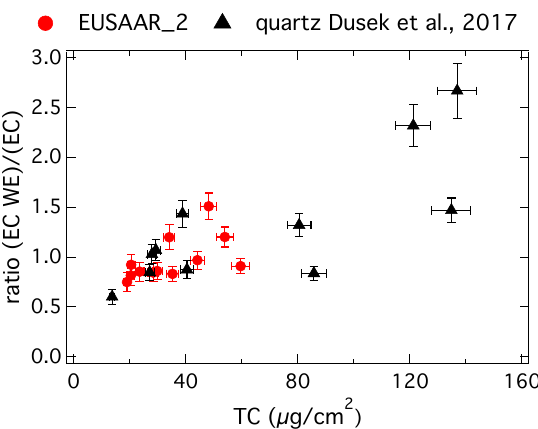
Figure 2. Ratio of the EC concentration on water-extracted (EC WE) and untreated (EC) filter samples versus the TC concentration on the untreated filter samples, red circles show results from this study determined with the EUSAAR_2 protocol and black triangles show results from Dusek et al. [9] determined with the QUARTZ protocol.